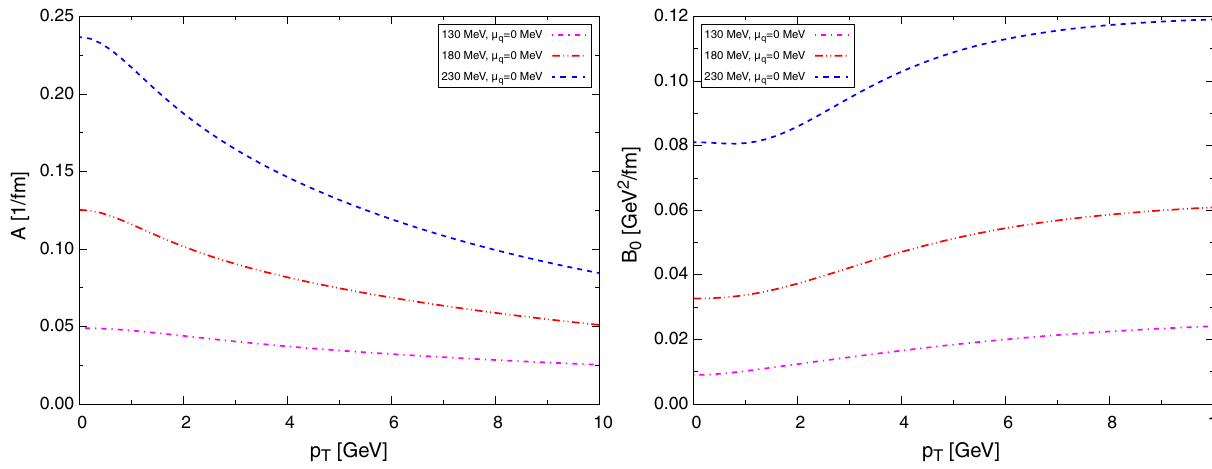
Fig. 1 Drag (left) and diffusion (right) coefficients in the resonance model for charm quarks at different temperatures